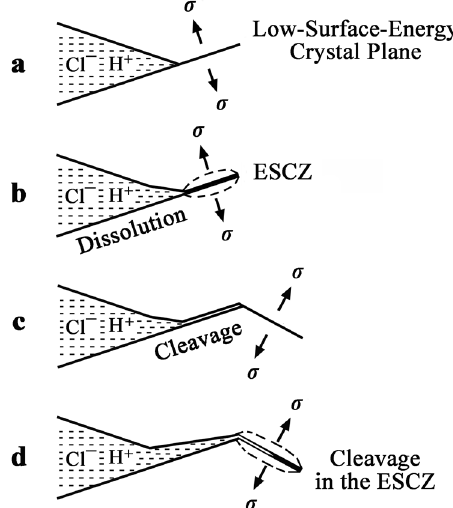
Fig. 3 A typical cleavage and dissolution process of SCC. a The anodic dissolution of the microscopic electric dipoles fi rst occurs at the crack tip, promoting the SCC advance and the stress concentra- tion. b An ESCZ is formed on front of the crack tip, in which the corrosive environment particles interact with the crystal planes and pin the intrinsic dislocations. c A corrosive environment particle adsorbed low-surface-energy cleavage plane, such as (1 0 0) in the type 316 L stainless steel, cleave at the normal stress level. d Another SCC microcrack nucleates through repetition of anodic dissolution, forming another ESCZ and brittle rupture of another low-surface- energy cleavage plane. SCC microcrack nucleates in the ESCZ, which induces SCC growth at a little distance toward. In this way, another fresh SCC microcrack is capable of nucleation, through repetition of anodic dissolution, formation of another ESCZ, and rupture of another low-surface-energy cleavage plane, schematically shown in the fi nal step in Fig. 3d.